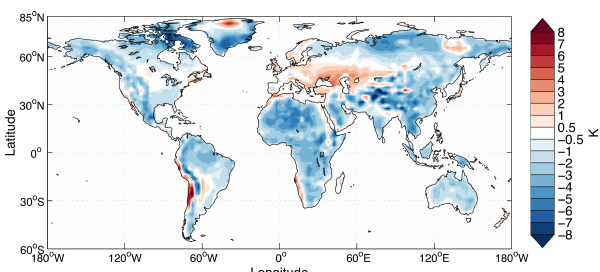
Fig. 6. Comparison of simulated air temperature at reference height over the ground surface with NorESM for 1976–2005 (Historical1) with the CRU TS3.1 (Mitchell and Jones, 2005) observational data-set for the same period interpolated to the same grid using conservative remapping. Global bias error is − 1.0868K with a RMSE of 2.347K.